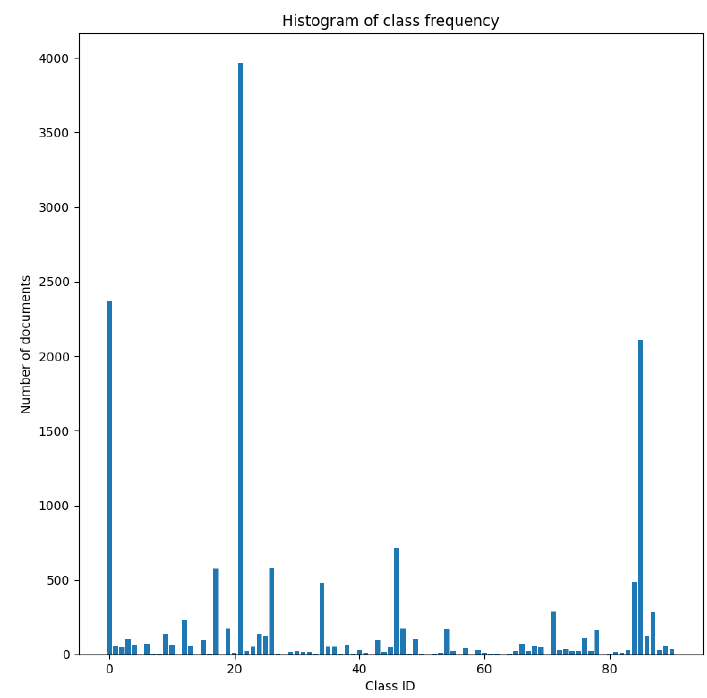
Figure 12. Class frequency distribution for Reuters.